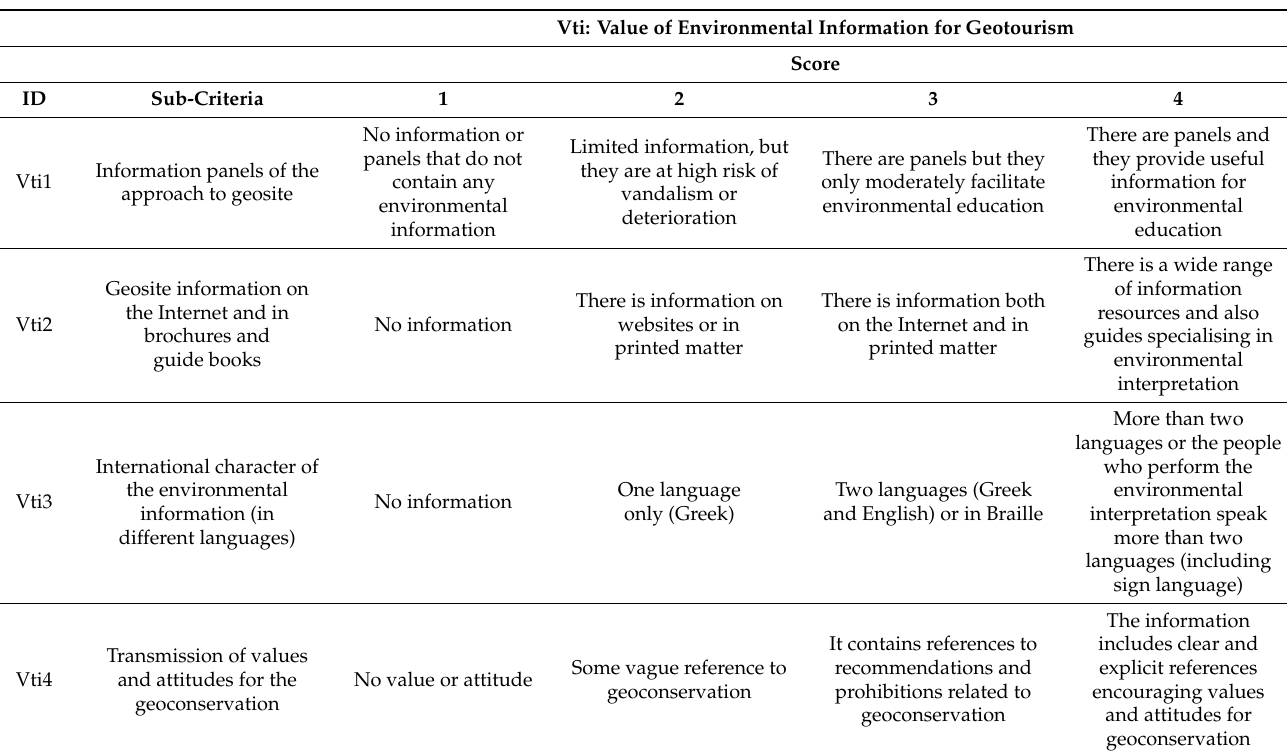
Table 6. Value for environmental information for geotourism and sub-criteria [64,65]. Vti: Value of Environmental Information for